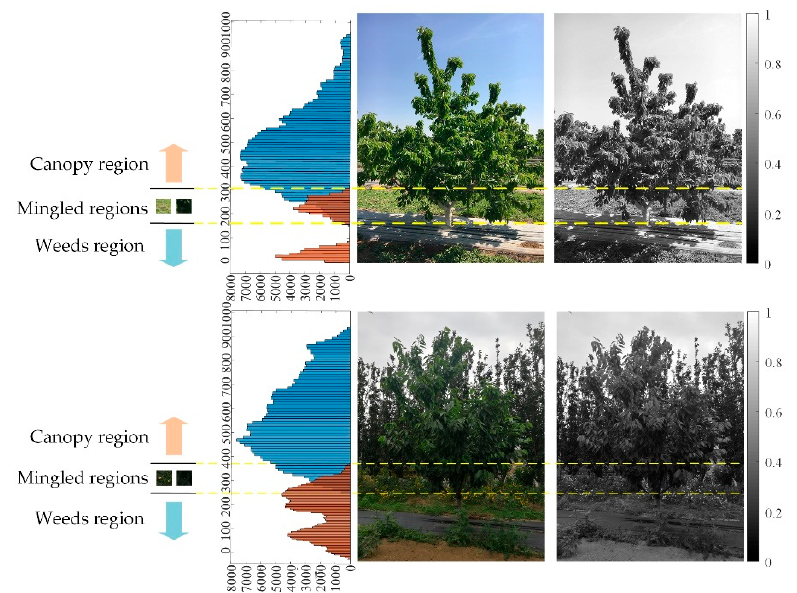
Figure 6. The illustrations of the brightness and height distribution of canopy under different lighting conditions. The yellow dotted lines indicate the mingled areas, and the color bar manifests brightness value. From left to right are the crown- and weed-height distribution, the original image and the brightness image; from top to bottom are the sunny fruit-tree images and cloudy fruit-tree images.